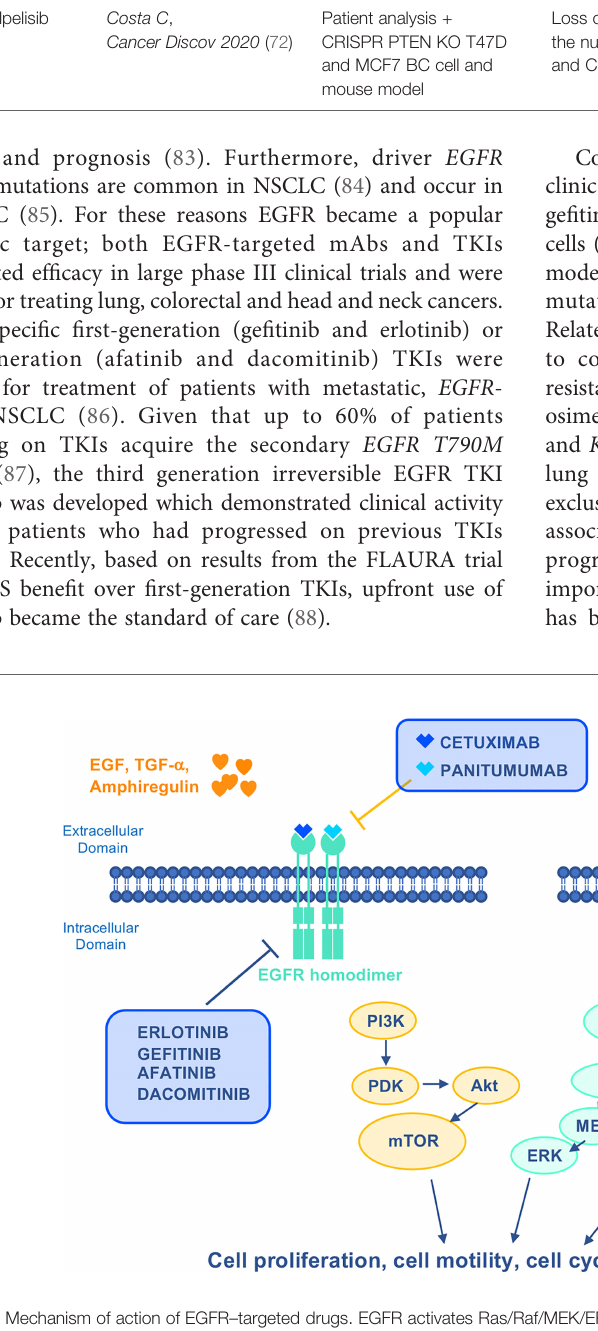
TABLE 2 | Cross – resistance in CDK4/6 – targeted therapies. Previous agent